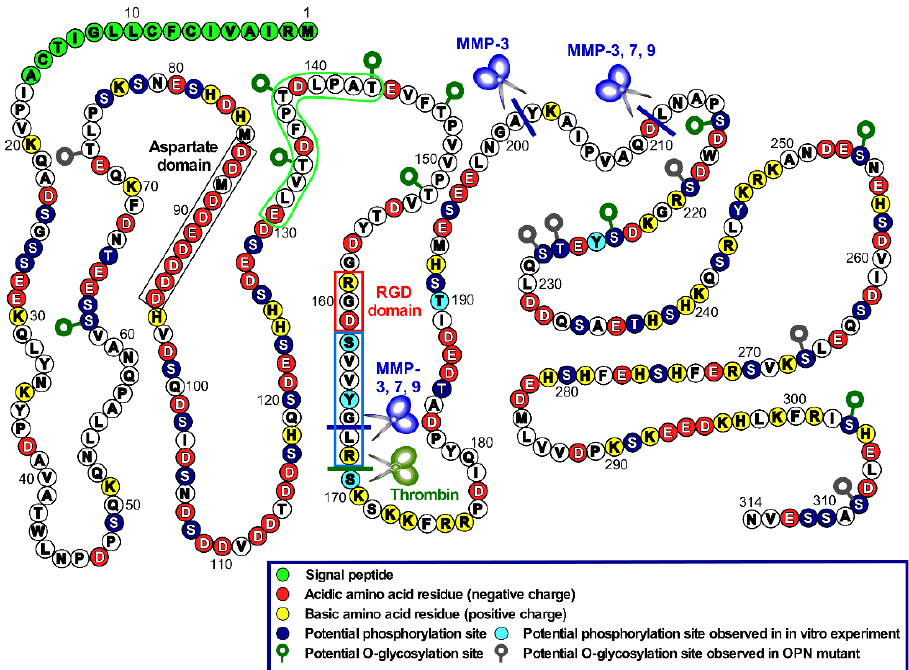
Figure 2. Primary structure and post-translational modifications of osteopontin. Potential phos- phorylation and O-glycosylation sites, protease cleavage sites, integrin binding and aspartate domains, and signal peptide are highlighted. Integrin binding domains (E 131 LVTDFPTDLPAT 143 , R 159 GD 161 , and S 162 VVYGLR 168 ) and aspartate domain (D 86 DMDDEDDDD 95 ) are in boxes.